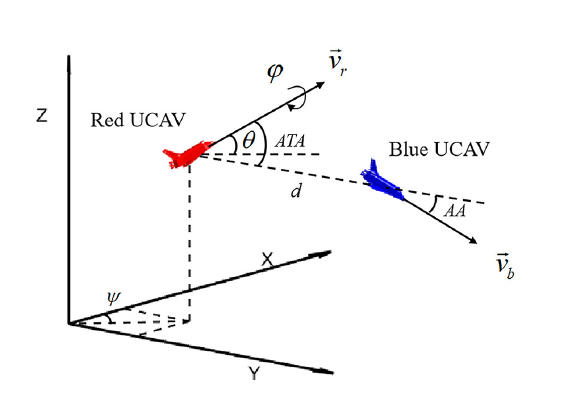
Figure 1. The state description of UCAVs in the three-dimensional coordinate